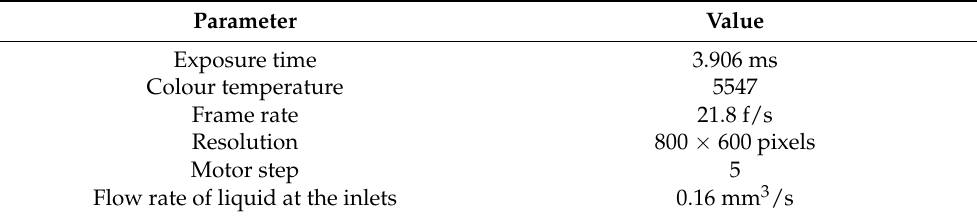
Figure 2. Schematic diagram of experimental setup. Table 1. Controlled parameters.